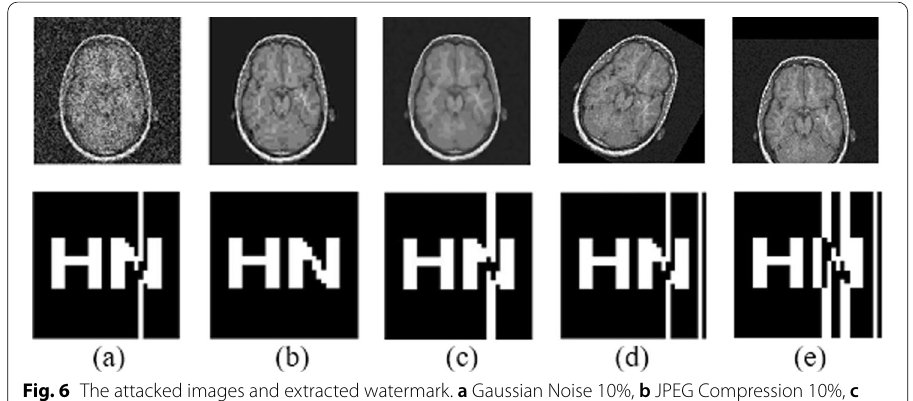
Fig. 6 The attacked images and extracted watermark. a Gaussian Noise 10%, b JPEG Compression 10%, c Median Filtering 5 5, d Rotation 30°, e moving down 10% ×